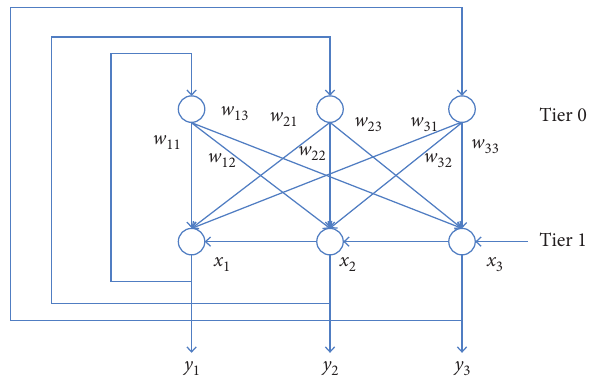
Figure 4: Discrete Hopfield network structure.